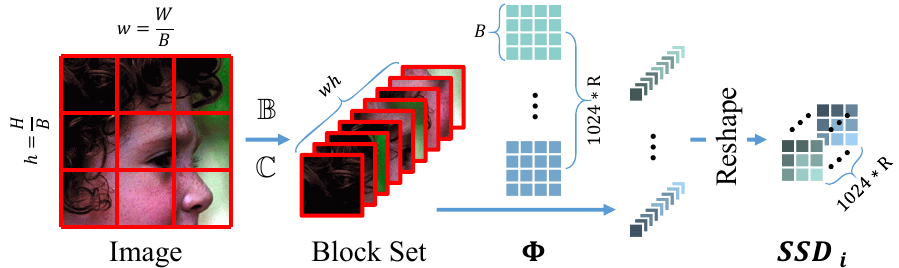
Figure 5. Parallel sampling module S ( · ) . The dimension of the sampling matrix Φ is set as 32 × 32 × ( 1024 × R ) . The input image of S ( · ) is divided into blocks with 32 × 32 pixels, which is the same size as one channel of Φ . The dividing line is shown in red, where w = W the number of blocks in the width and height, respectively. The block set will be sampled as a 1 × 1 × ( w ∗ h ) measurement for a total of 1024 × R parallel executions. Therefore, the sampling rate = R can be understood as 1024 × R 32 ∗ 32